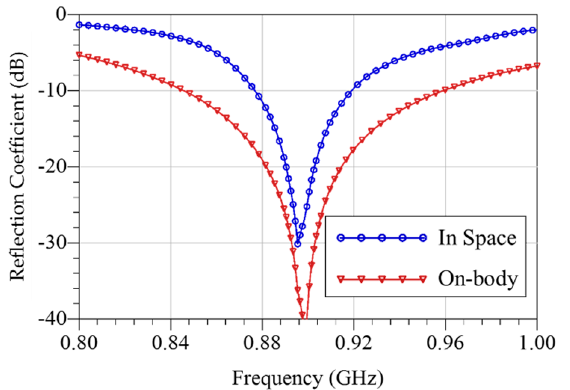
Figure 3. Measured return loss of the single-thread monopole, with a large ground plane, showing a 4.6% fractional impedance bandwidth. Table 1. Single-thread monopole antenna characteristics. In